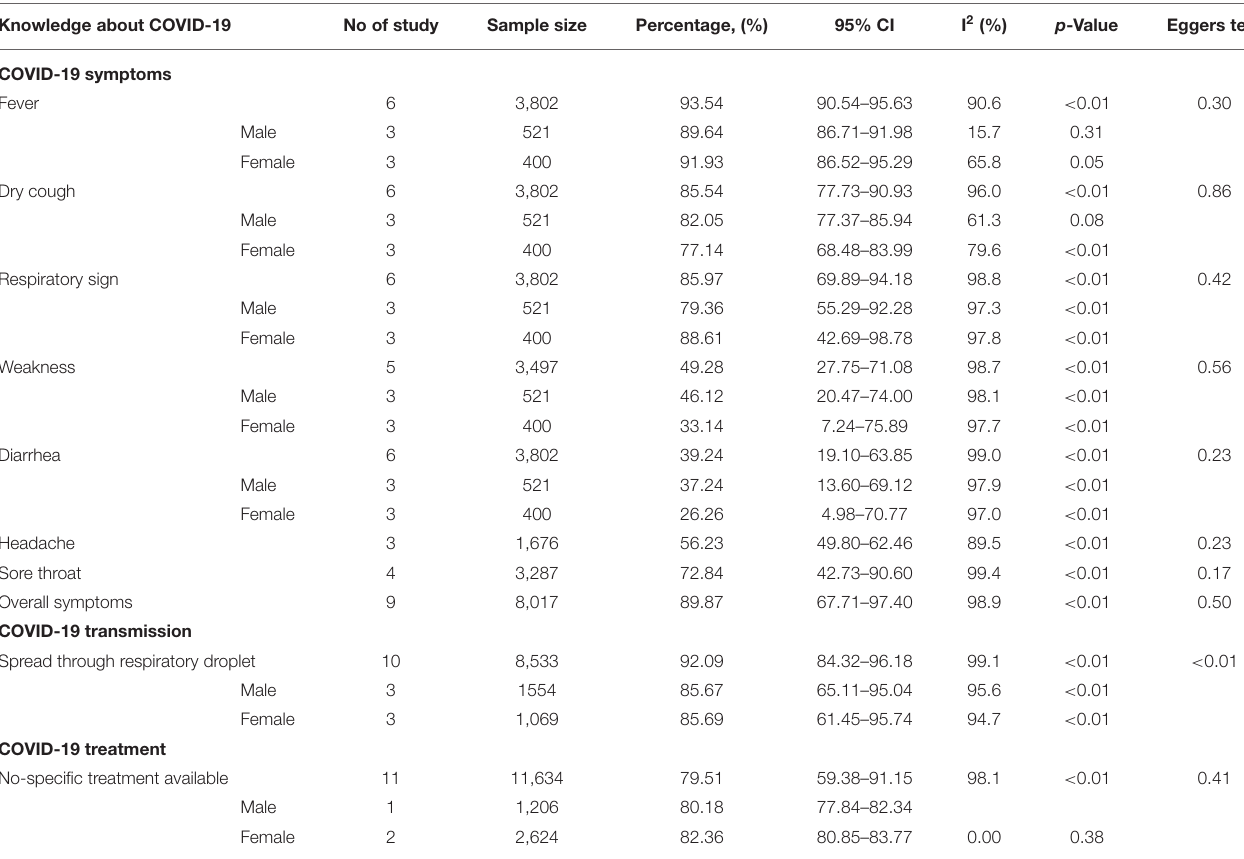
TABLE 2 | Pooled prevalence of knowledge about COVID-19 among Bangladeshi residents. Knowledge about